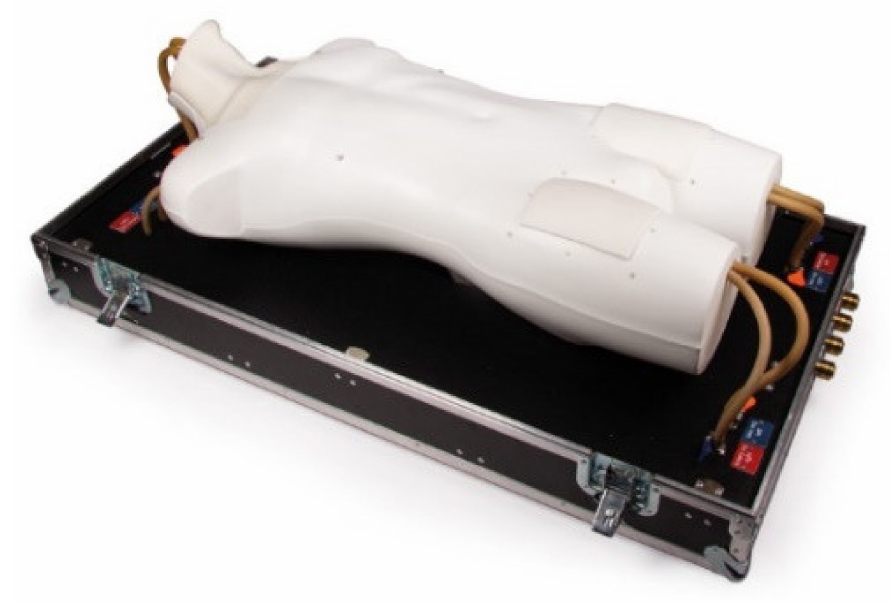
Figure 5. Erler Zimmer adult cannulation simulator [15].